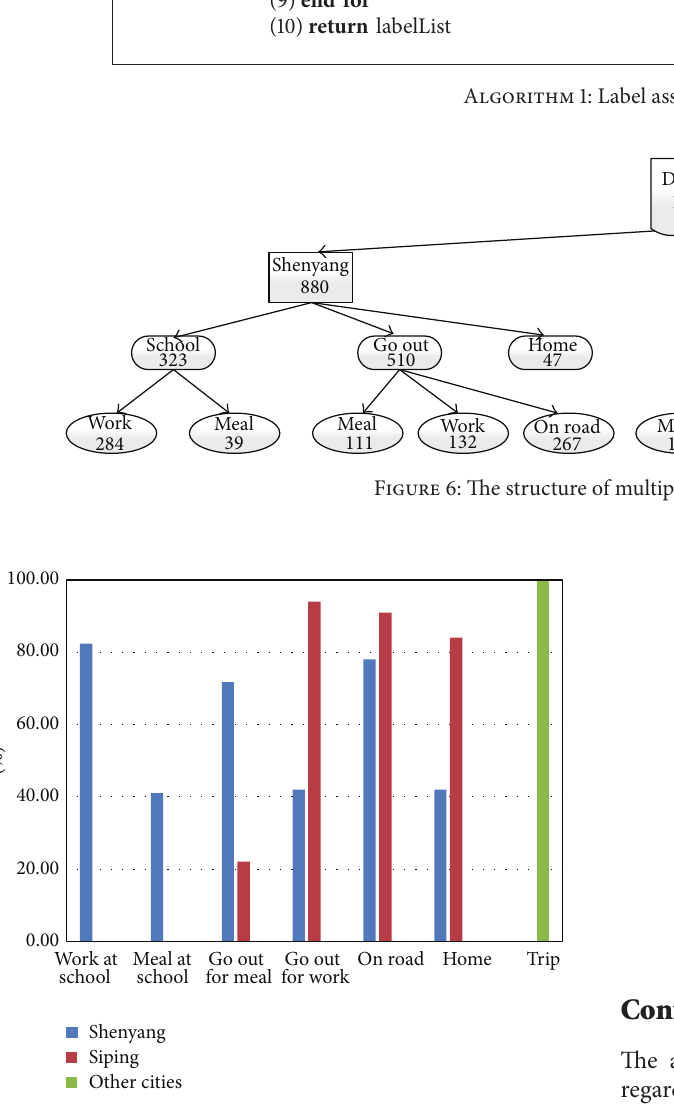
Figure 7: The accuracy of the multiple classifications.